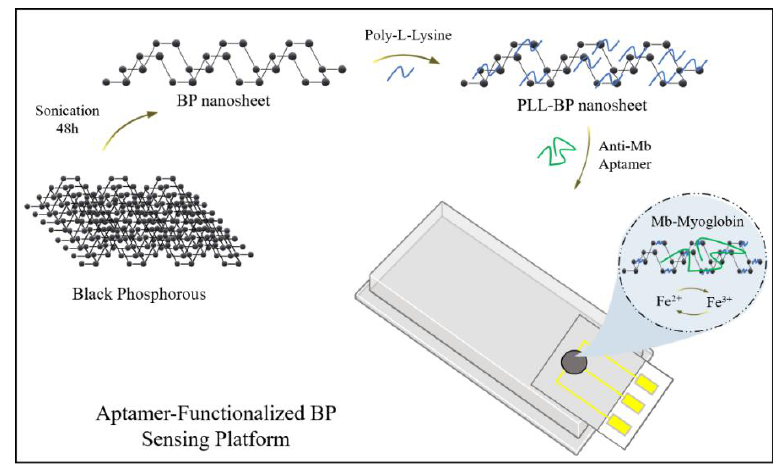
Figure 4. Aptamer-functionalized BP sensing platform for detection of Myo- globin.